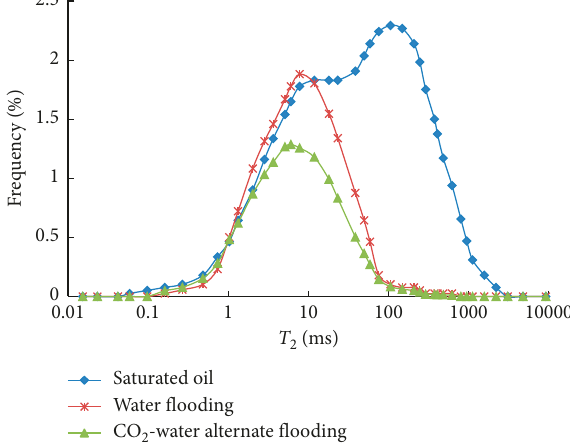
Figure 7: Distribution of residual oil with T alternate 2 during CO 2 flooding.